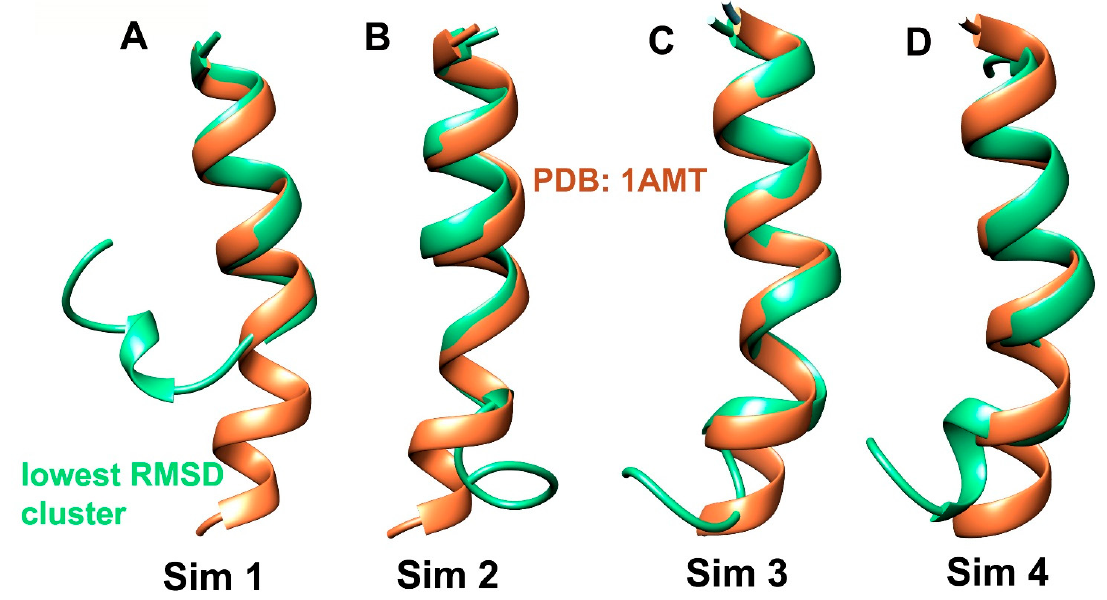
Figure 1. The representative structures of different clusters obtained for individual simulation chosen based on lowest RMSD with X-ray crystallographic Alm F30/3 structure available from PDB: